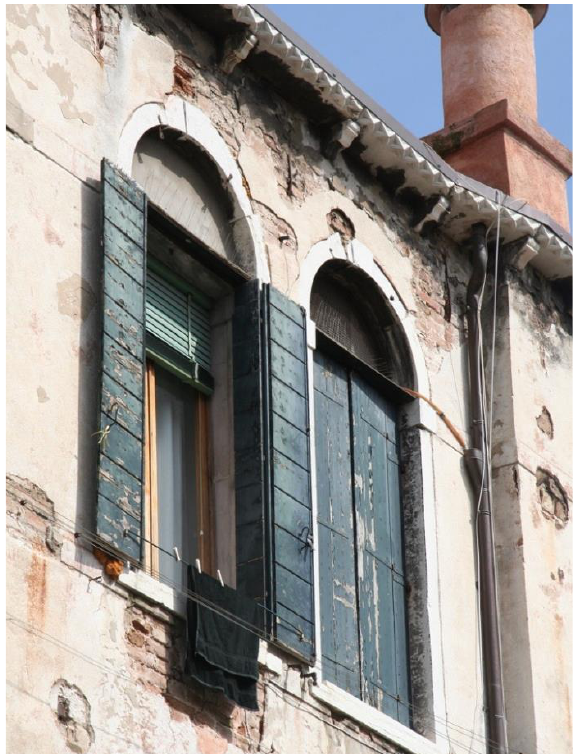
Figure 1. Windows of a historical building visible from a field of wells in the Castello district.